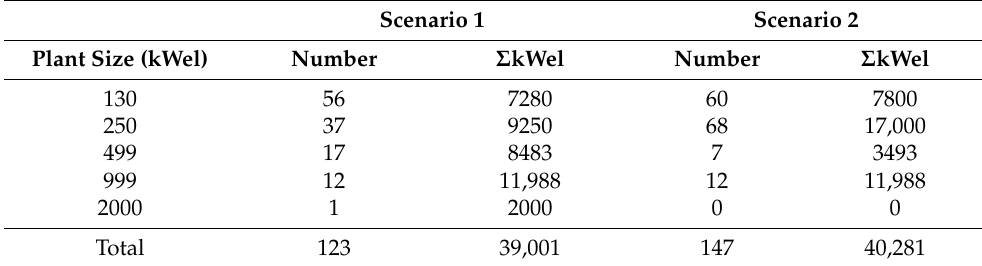
Table 8. Simulated biogas plants and related installed power (Scenarios